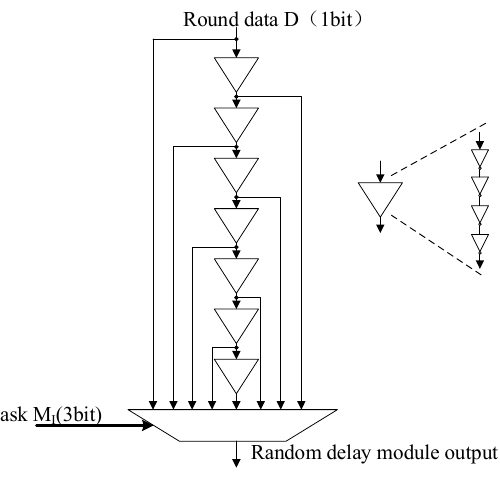
Figure 3. Random delay module diagram.